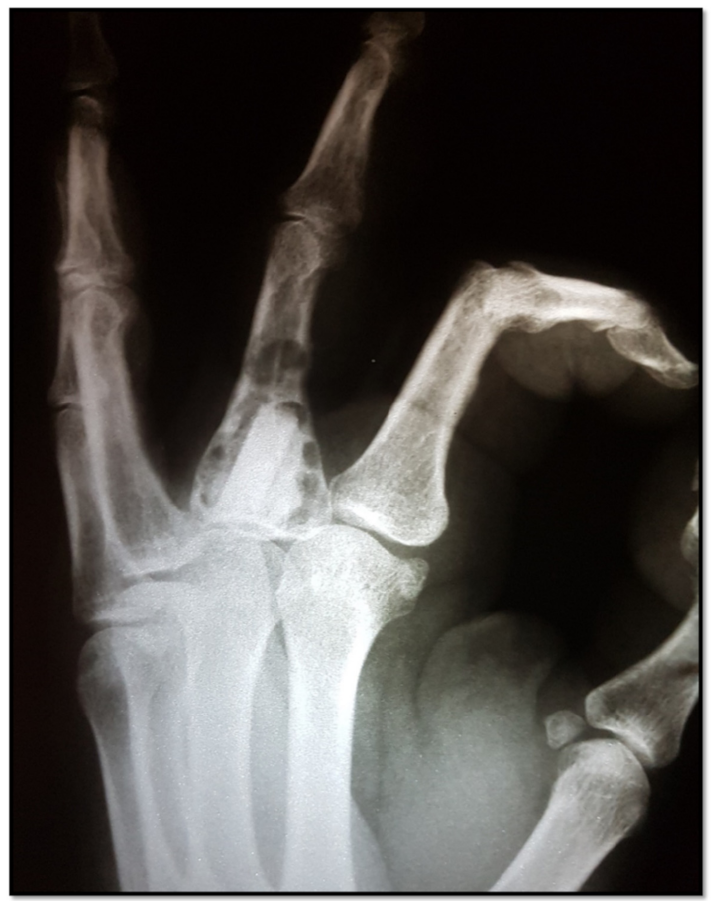
Figure 4. Enchondroma recurrence at 1-year post curettage and autologous bone